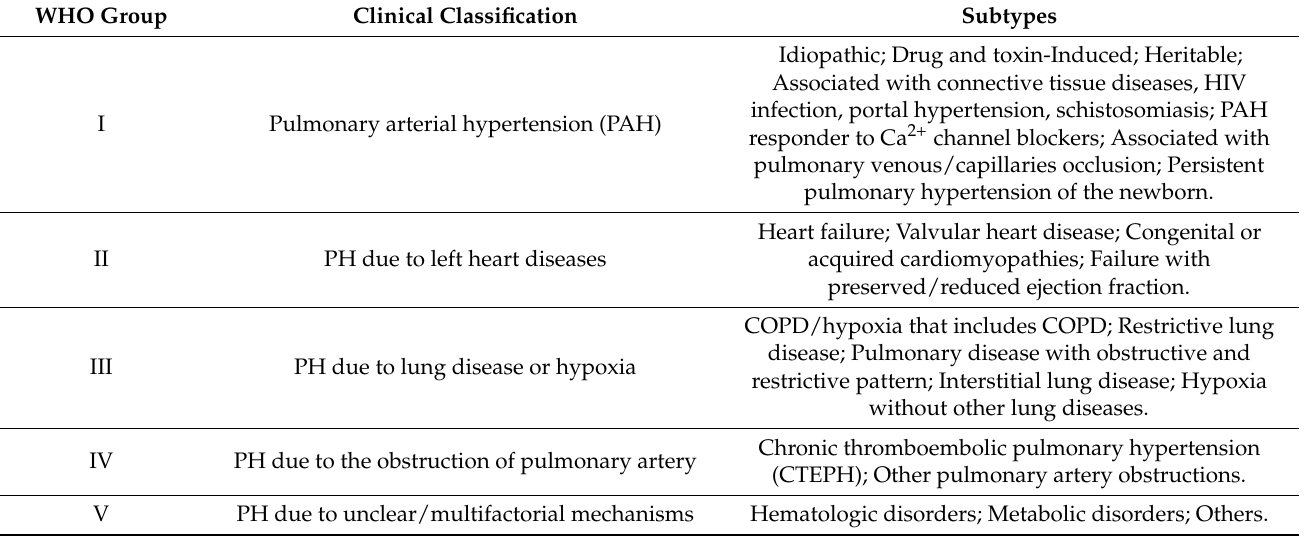
Table 1. WHO classification of pulmonary hypertension